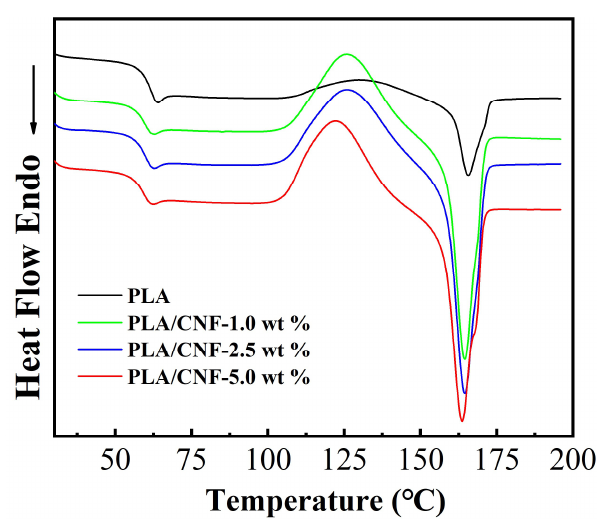
Figure 8. Differential scanning calorimetry (DSC) curves of second heating for neat PLA and Figure 8. Di ff erential scanning calorimetry (DSC) curves of second heating for neat PLA and PLA / CNF PLA/CNF biocomposite films. biocomposite films. Table 2. DSC thermal characteristics of PLA and PLA/CNF nanocomposites.